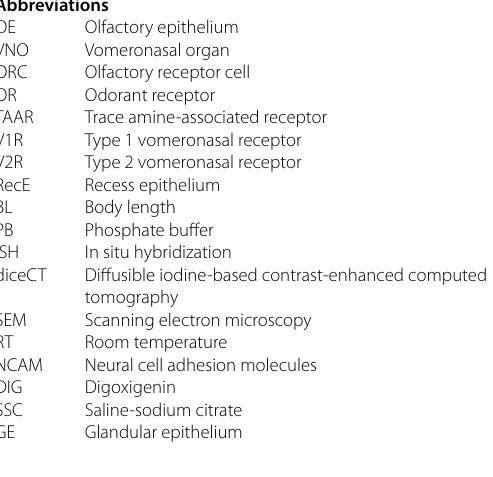
SD ( n 5–33, see Table 6). In ± =